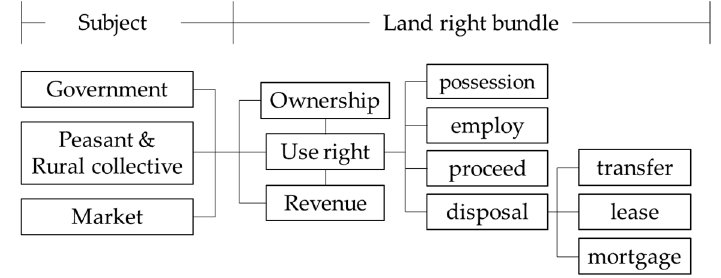
Figure 1. Land property rights of collective-owned construction